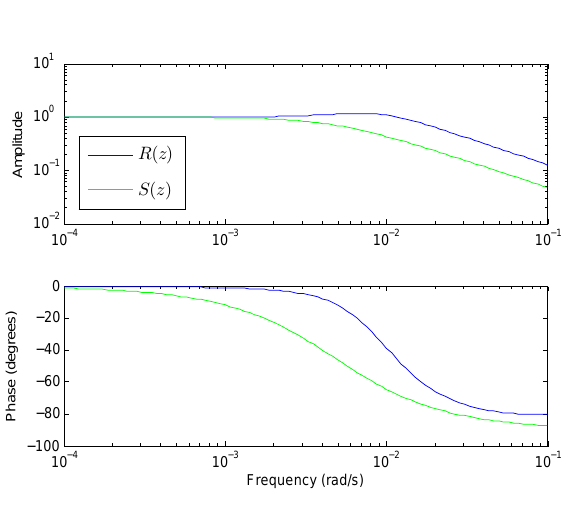
Figure 17: Bode diagram of the models R ( z ) and S ( z ).